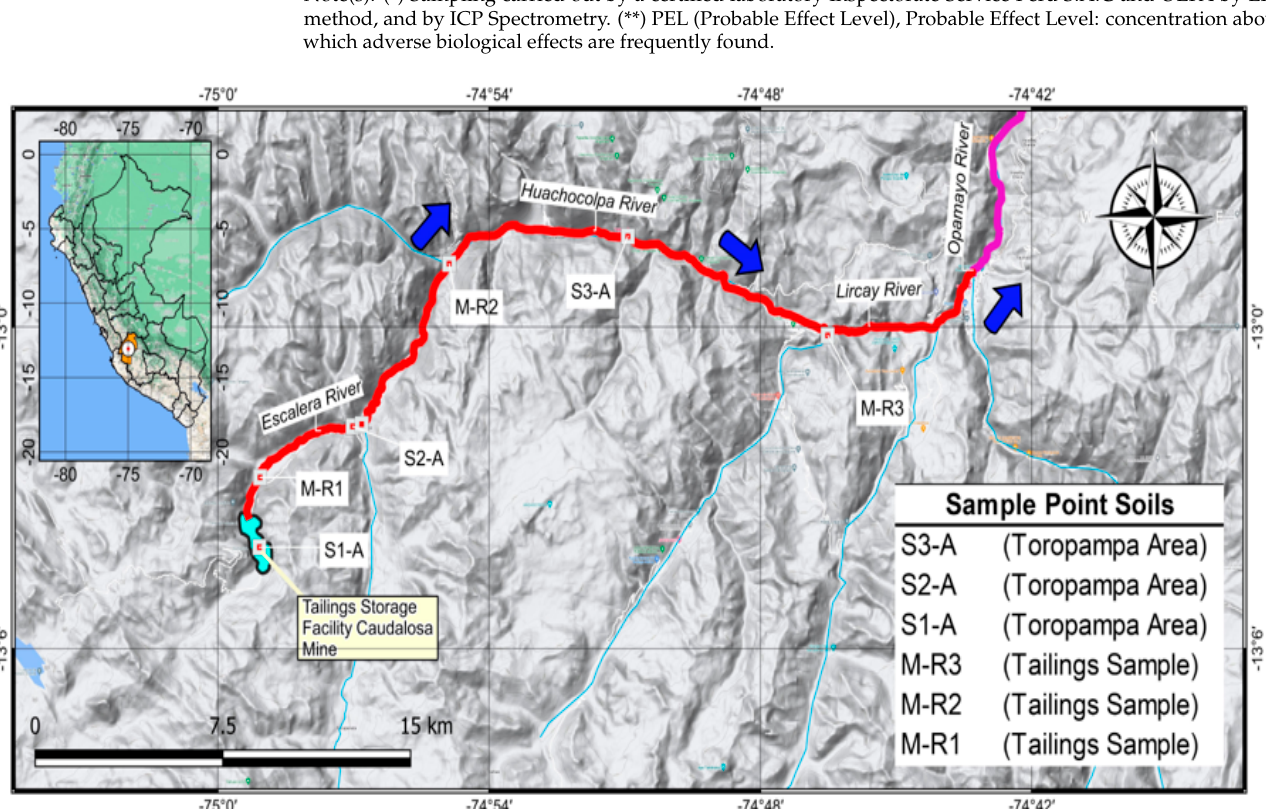
Table 3. Soil Quality and Tailings Monitoring Compared to Soil Standards [45].